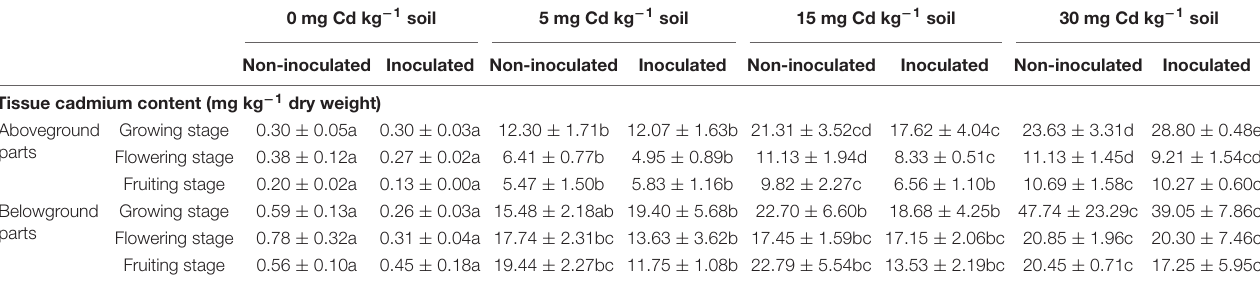
TABLE 1 | Effects of endophyte FZT214 on Cd accumulation in aboveground and belowground tissues of D. ambrosioides grown under different Cd concentrations at different developmental stages (mean ± STD, n =